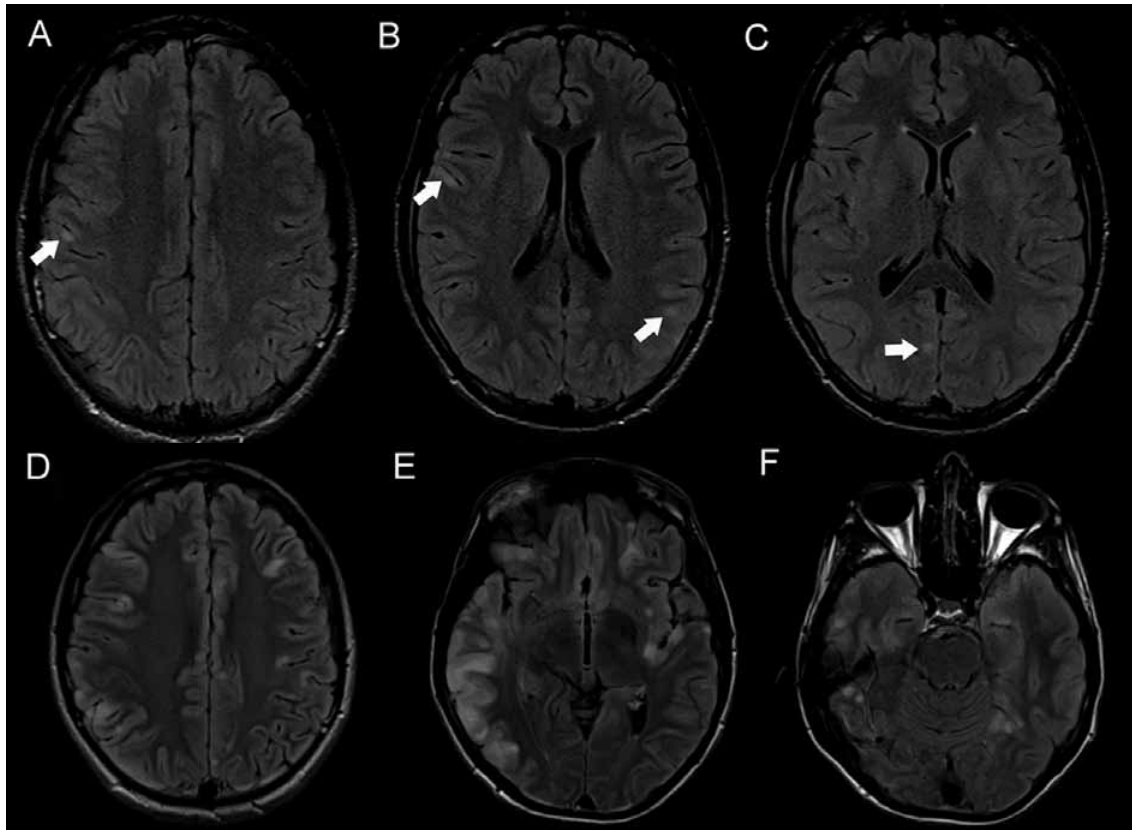
Figure 1. A-C - presence of several subtle foci of increased signal on fluid-attenuated inversion recovery (FLAIR) sequence, associated with restricted diffusion signal on diffusion weighted imaging (DWI) sequence, involving only the cortex on several locations in both cerebral hemispheres. D-F - enlargement of inflammatory